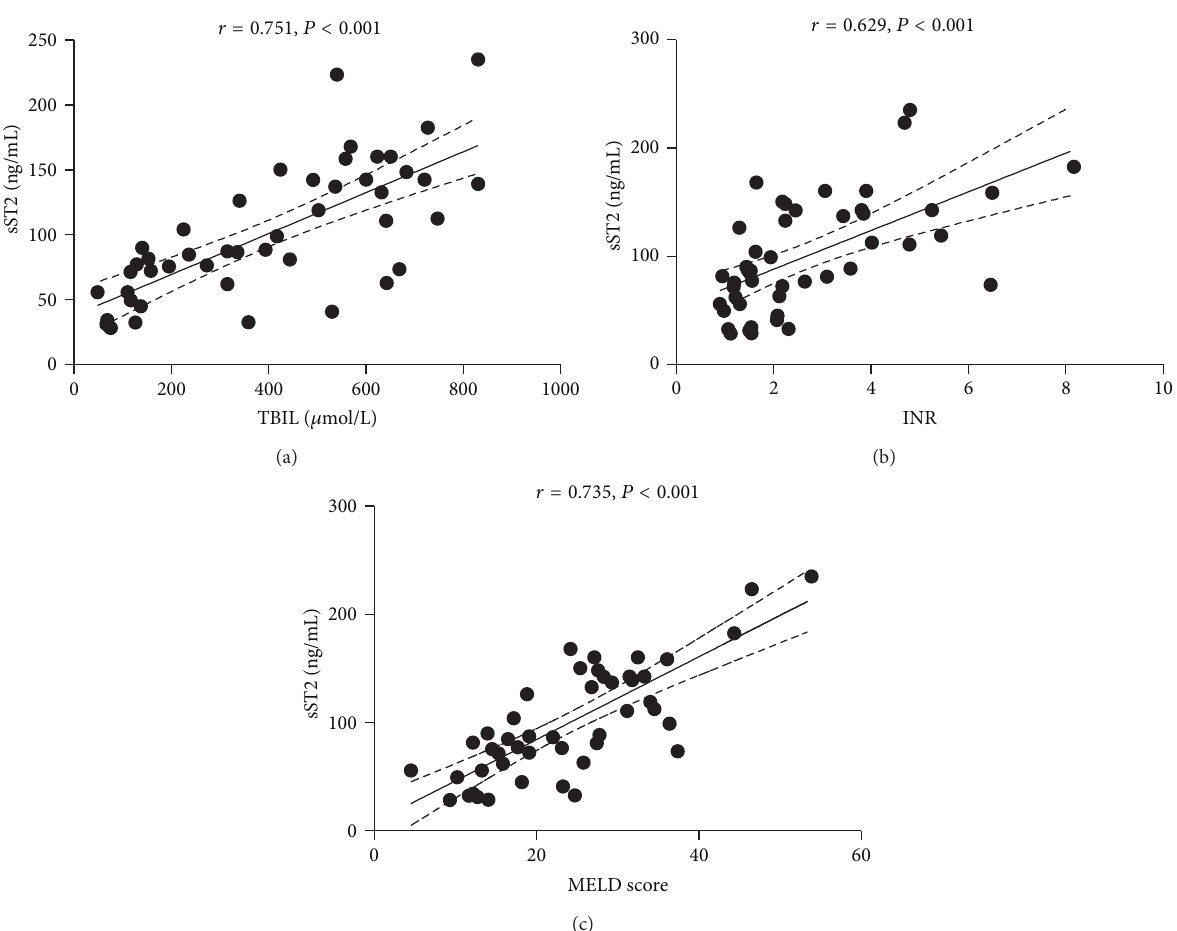
Figure 6: Correlations between soluble ST2 (sST2) and total bilirubin (TBIL), prothrombin time international normalized ratio (INR), and model for end-stage liver disease (MELD) score in week 3. Graphic representation of correlations between sST2 and (a) TBIL, (b) INR, and (c) MELD